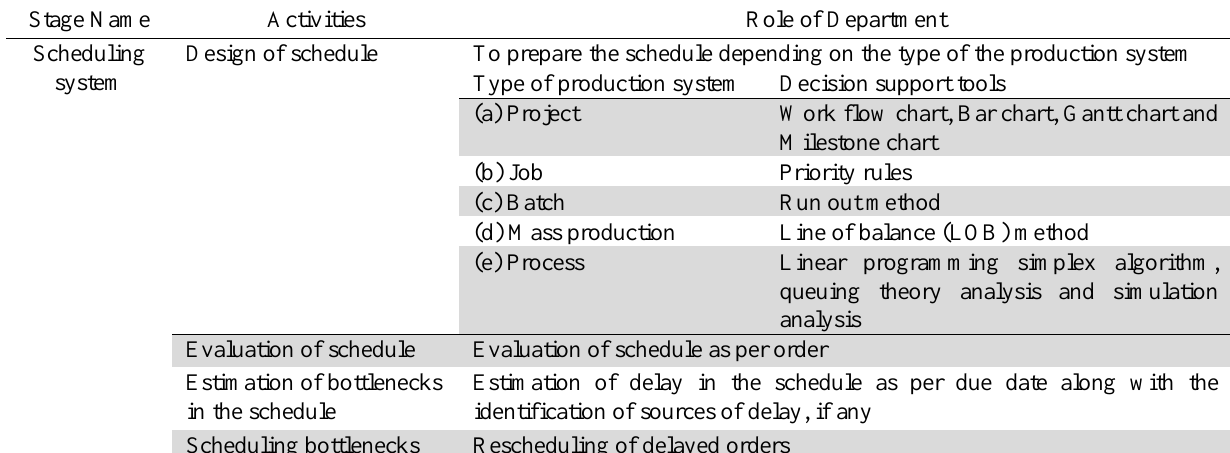
Key activities of scheduling system stage